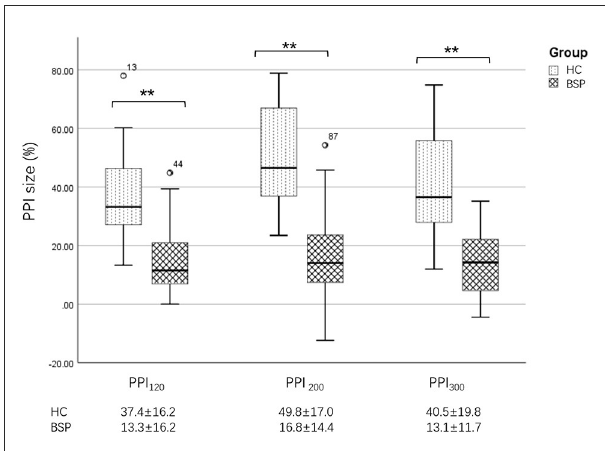
FIGURE3 Differences in PPI size between the HC and BSP groups. PPI 120 , prepulse inhibition at ISIs of 120ms; PPI 200 , prepulse inhibition at ISIs of 200ms; PPI 300 , prepulse inhibition at ISIs of 300ms. All comparisons were performed using the independent-sample t -test. ** p < 0.01.